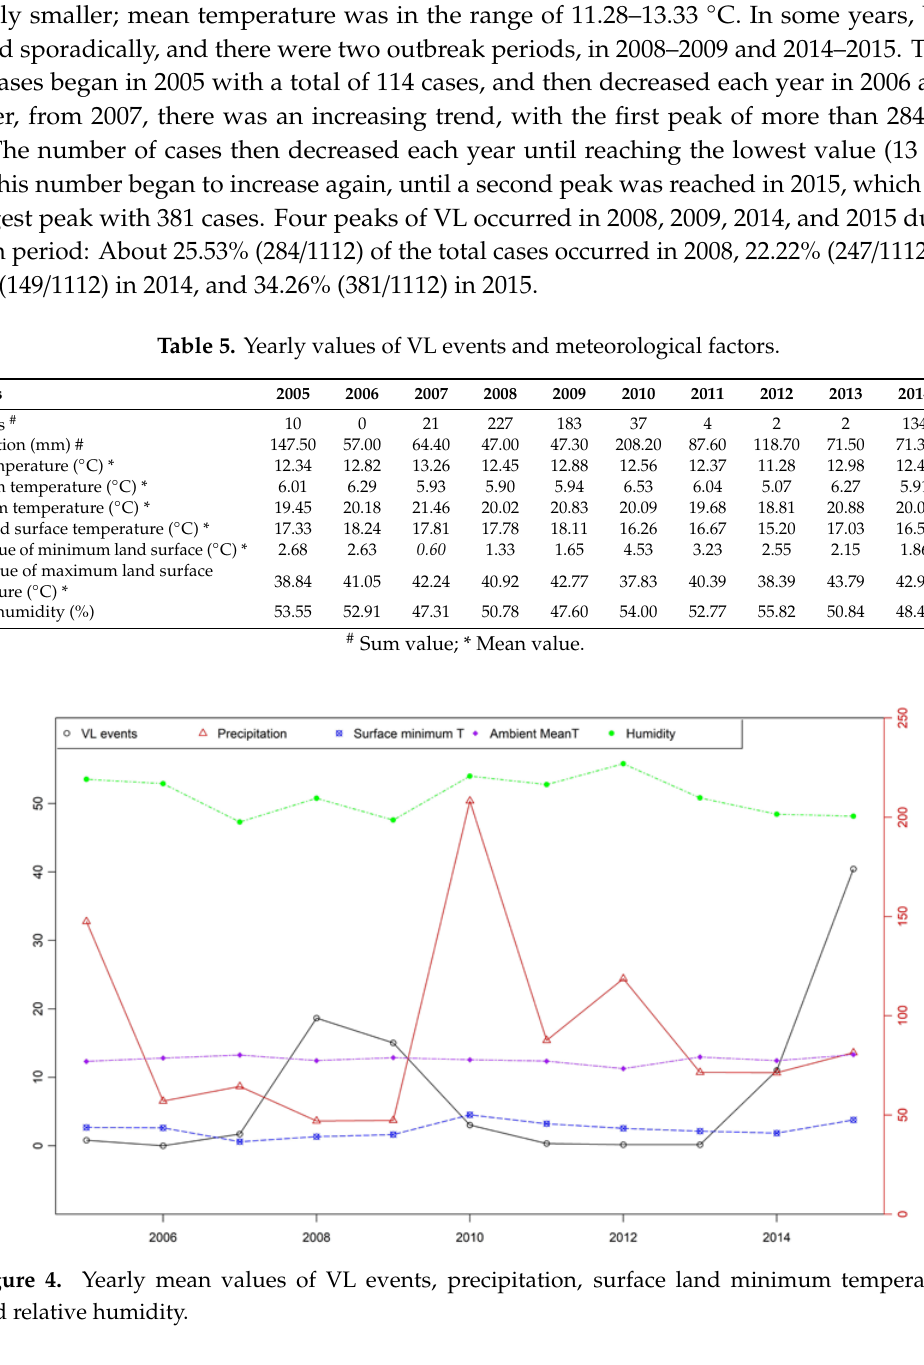
Table 5. Yearly values of VL events and meteorological factors.